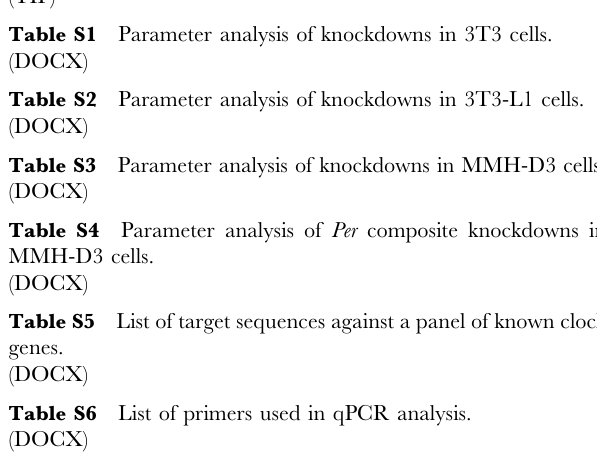
Figure S1 Outline of generation of lentiviral shRNAs for gene knockdown.